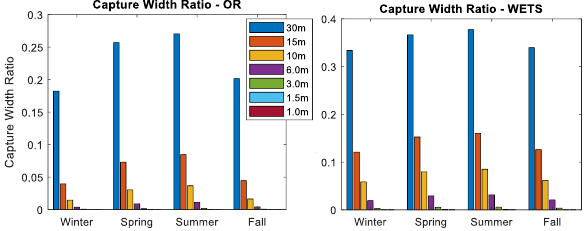
Figure 12: Capture Width Ratio for various WEC sizes in Oregon and Hawaii